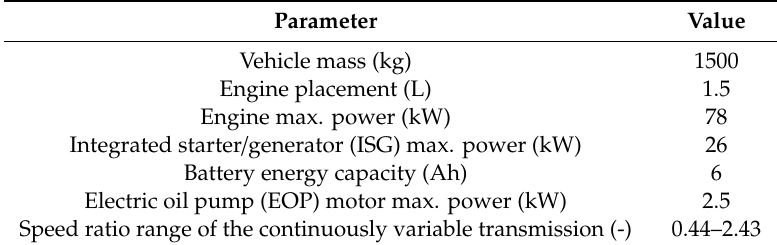
Figure 1. Vehicle Configuration. Table 1. Vehicle Parameters.